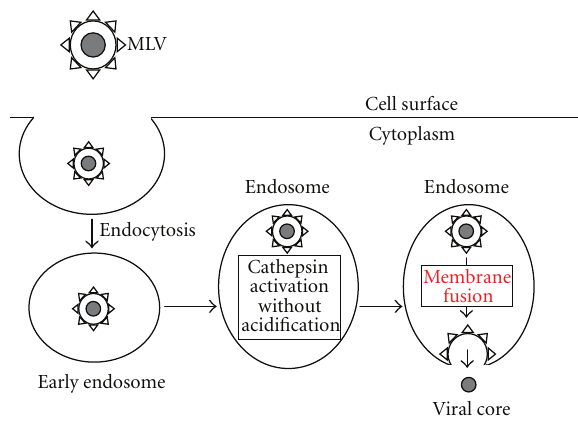
Figure 3: Entry pathway of ecotropic MLV in XC cells. Ecotropic MLV entry in XC cells may occur in acidic late endosomes, but endosome acidification is not required for the